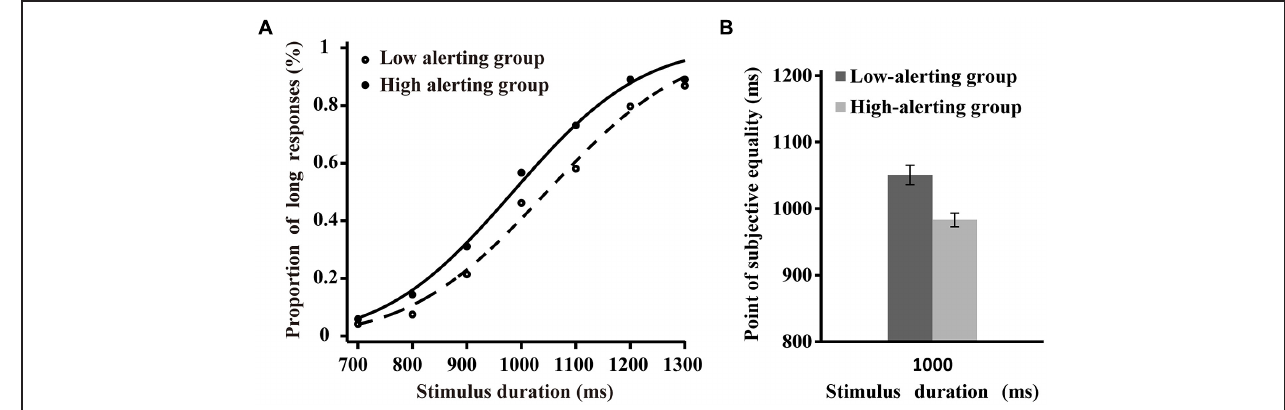
FIGURE 2 | Difference between the high alerting efficiency and low alerting efficiency groups in the temporal bisection task. (A) Proportion of “Long” responses plotted as a function of stimulus duration for two groups. The lines are the best-fit cumulative Gaussian with two parameters. (B) Difference of the point of subjective equality between two